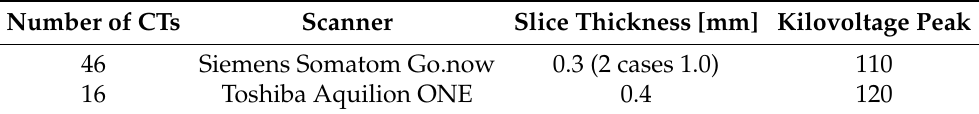
Table 1. Dataset